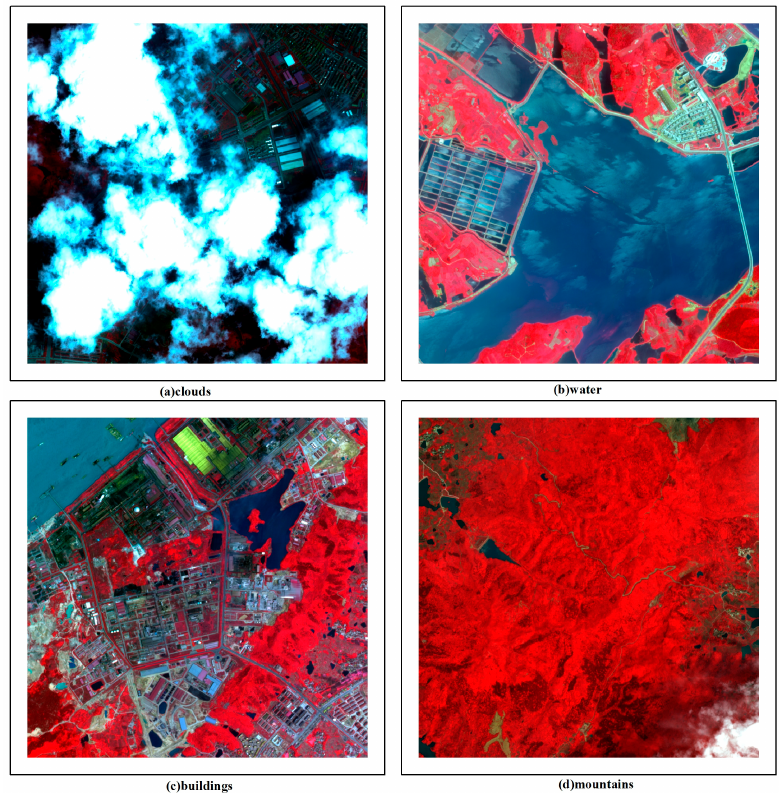
Figure 3. Image textures for: ( a ) clouds; ( b ) water; ( c ) buildings and ( d ) mountains. Near infrared red, red and green bands are chosen for making these false color images.